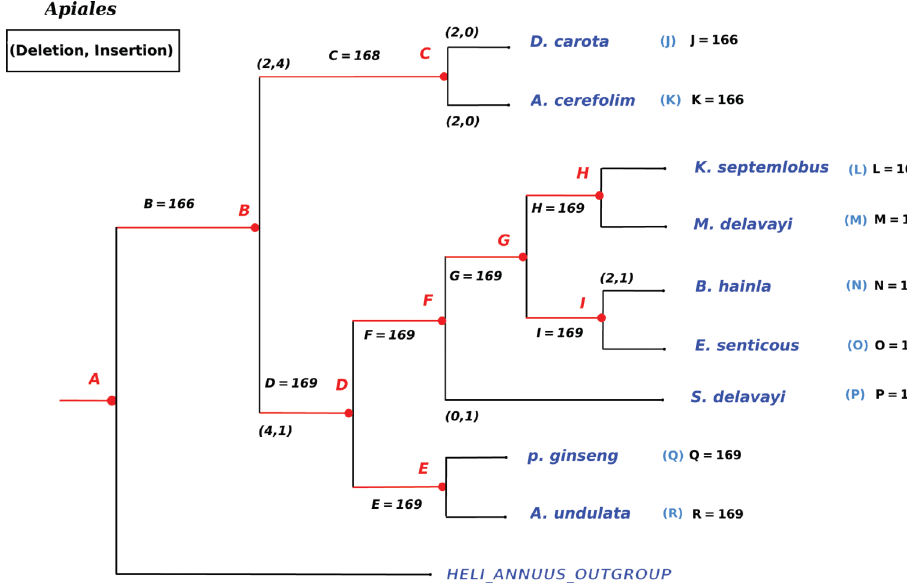
Figure 7: Insertion and deletion events found during ancestor reconstruction on Apiales order. Letters in red refer to ancestor genomes (their lengths are provided